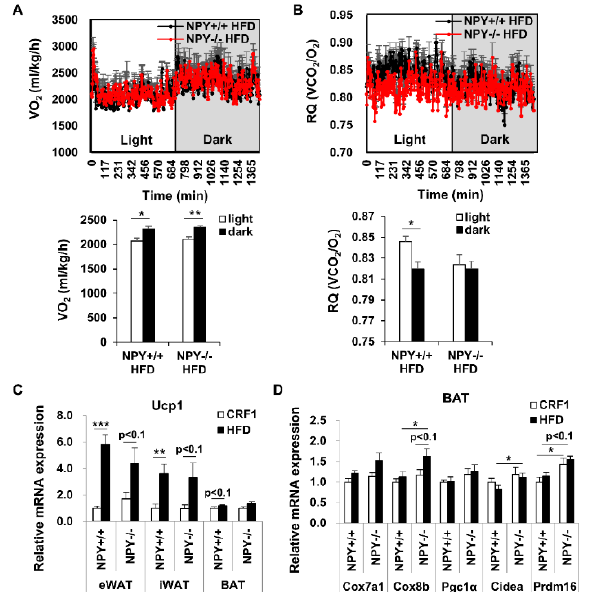
Figure 2. NPY deficiency enhances brown adipose tissue (BAT) thermogenesis. ( A ) Oxygen consumption (botom: average oxygen consumption), ( B ) Respiratory quotient consumption (botom: average respiratory quotient) for 24 h in WT and KO mice-fed HFD ( n = 4 per group), ( C ) mRNA expression level of UCP1 in eWAT, iWAT and BAT, ( D ) mRNA expression level of thermogenesis-related genes in BAT from WT and KO mice ( n = 5–6 per group). All data are presented as the mean ± SEM. Statistical significance was determined by two-way analysis of variance (ANOVA) with Bonferroni’s multiple-comparisons test or Student’s two-tailed t test, * p < 0.05, ** p < 0.01, and *** p <